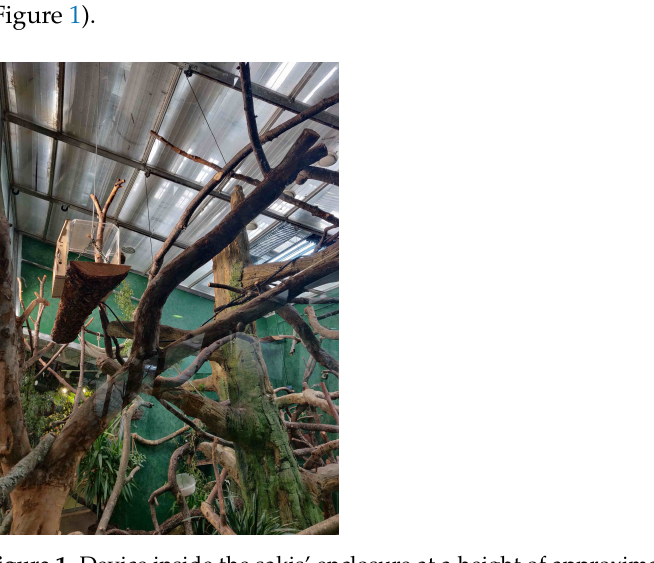
Figure 1. Device inside the sakis’ enclosure at a height of approximately 3.5 m from the